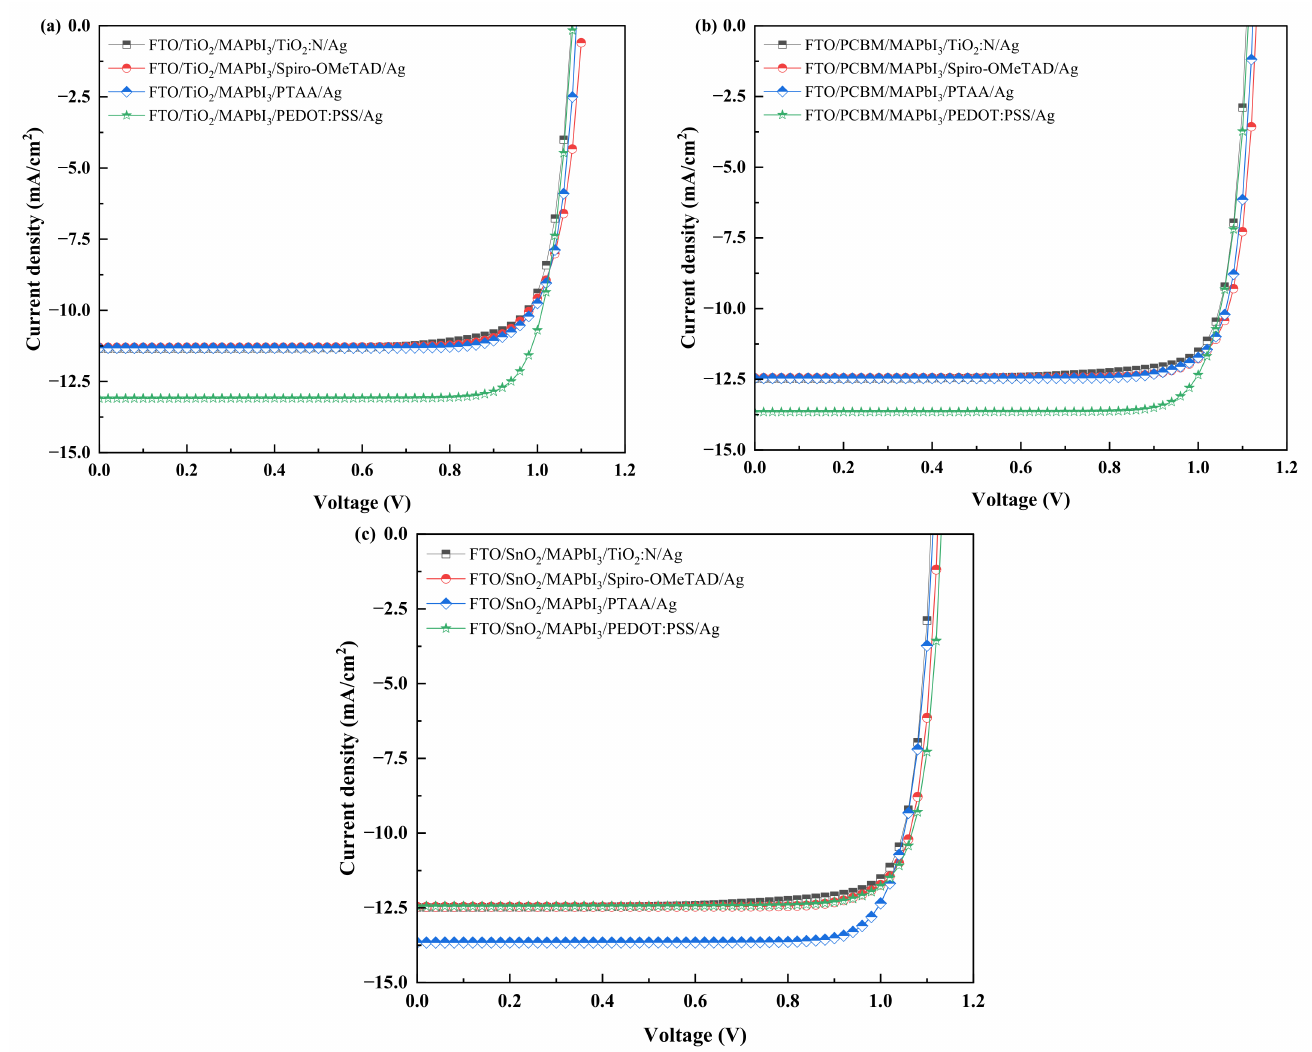
Figure 3. J-V characteristics of the PSC structures with four HTLs and the ETL as: ( a ) TiO 2. ( b ) PCBM. ( c ) SnO 2